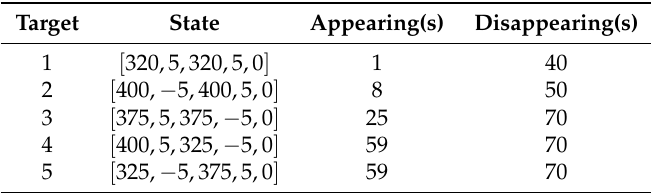
Table 4. Initial states of the